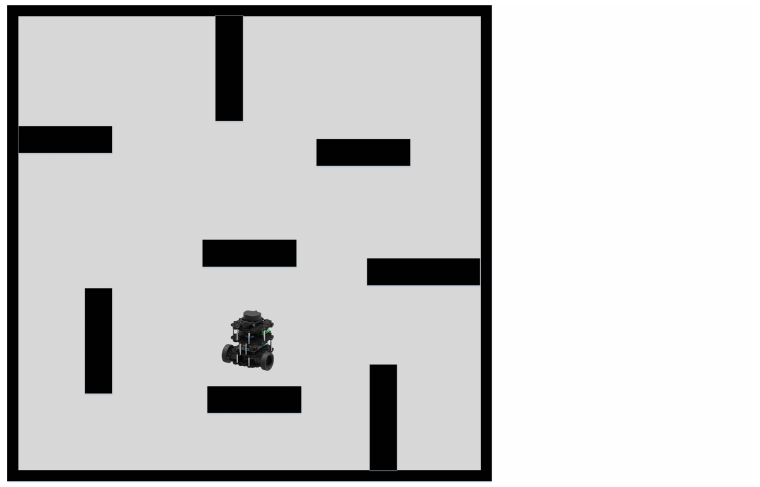
Figure 6. Static